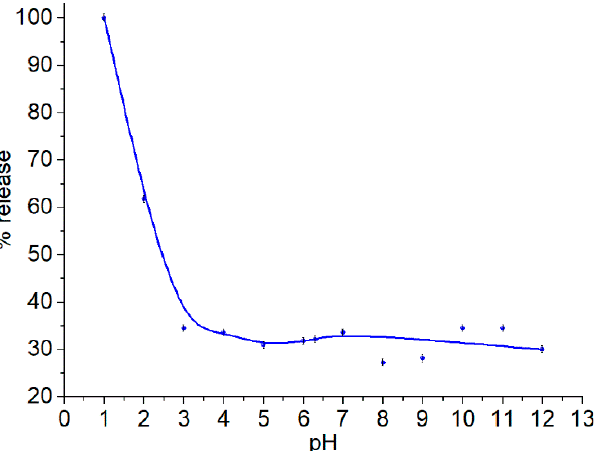
Figure 3. The release of inhibitors at different pH. Standard deviation was less than 0.9% for each depicted data point.